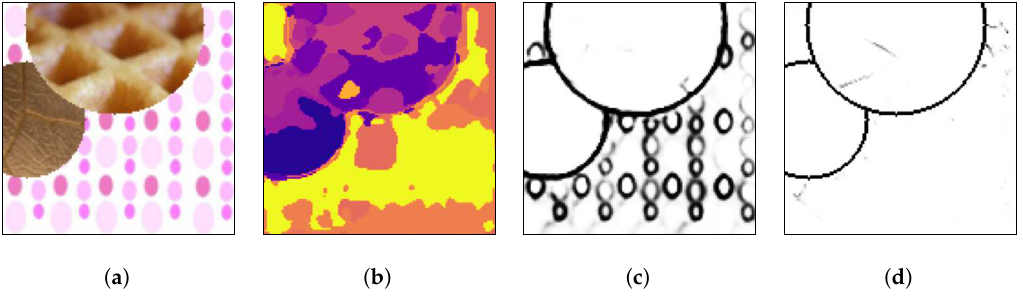
Figure 10. ( a ) An example mosaic, ( b ) the results of a multi-class labeling approach, ( c ) a HED architecture, and ( d ) the proposed